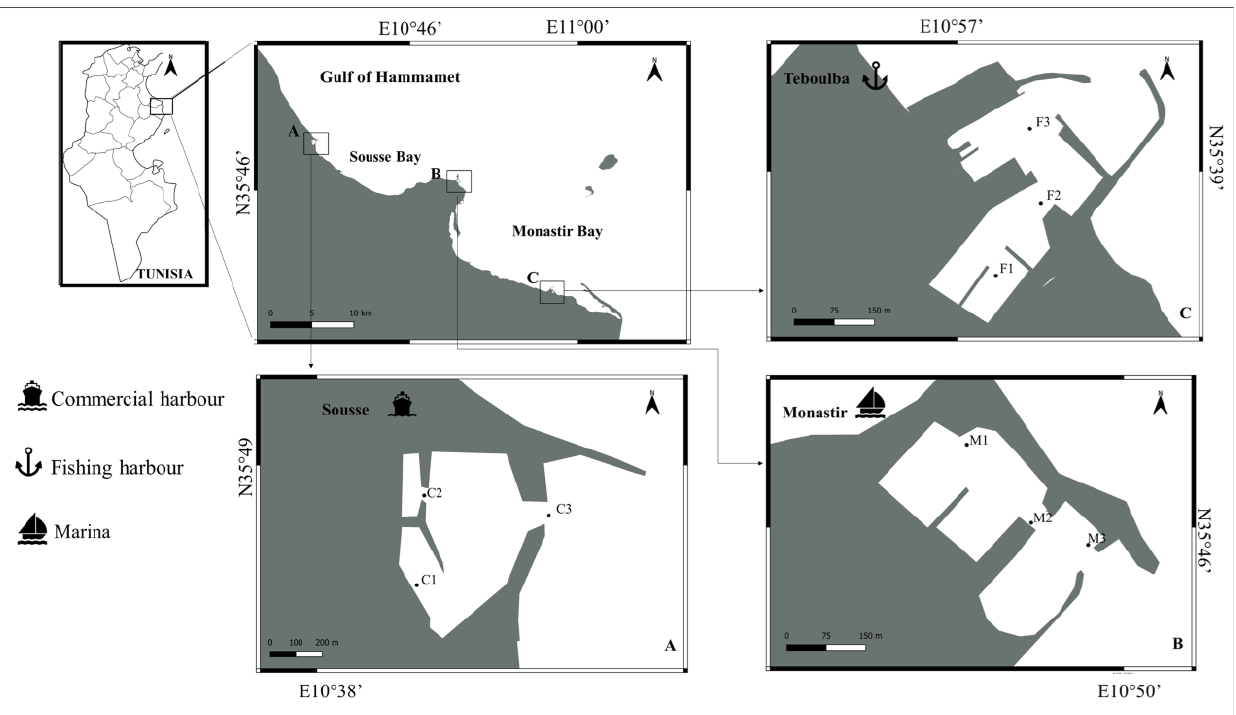
Figure 1. Map of the study areas showing location of sampling stations. ( A ): commercial harbour of Sousse, ( B ): Monastir marina, ( C ): fishing harbour of Teboulba.